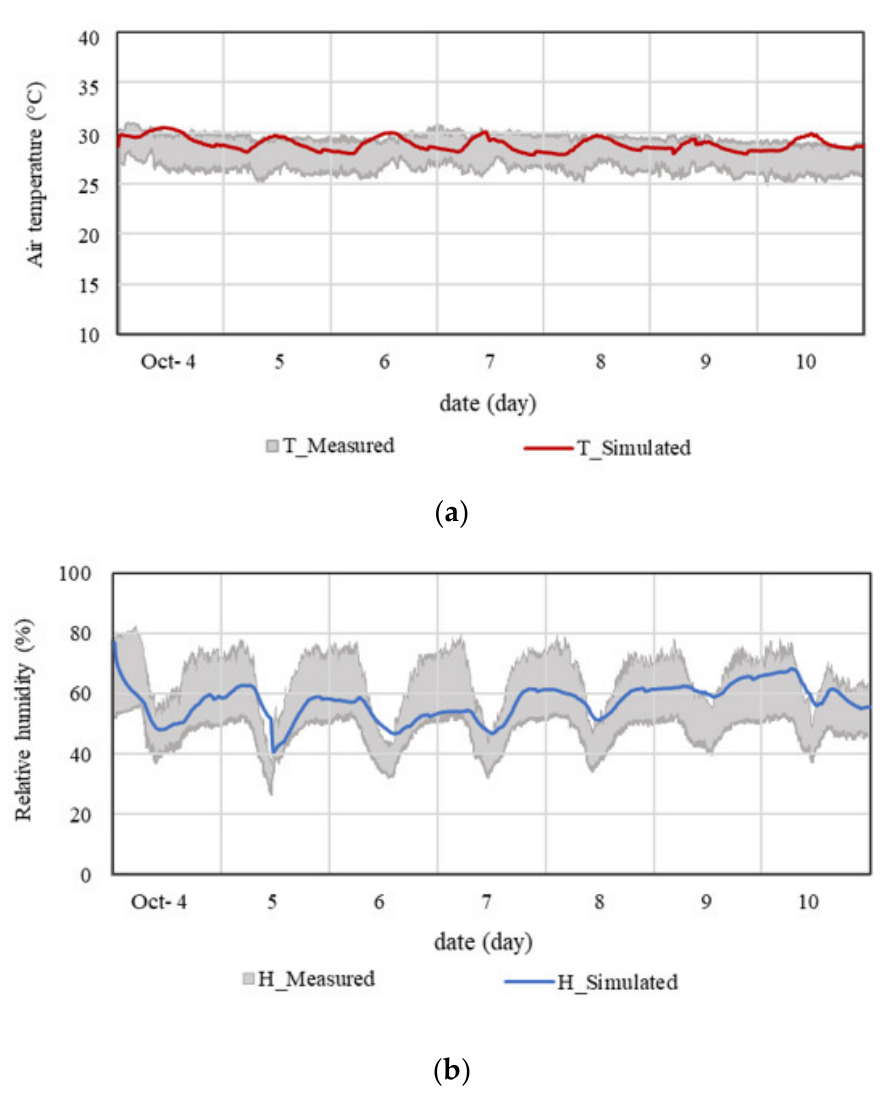
Figure 10. Comparison of internal air temperature and relative humidity for model validation: ( a ) Simulated value of air temperature compared to field measured data; ( b ) Simulated value of relative humidity compared to field measured data. Table 5. Statistical analysis by air temperature and humidity for model validation.